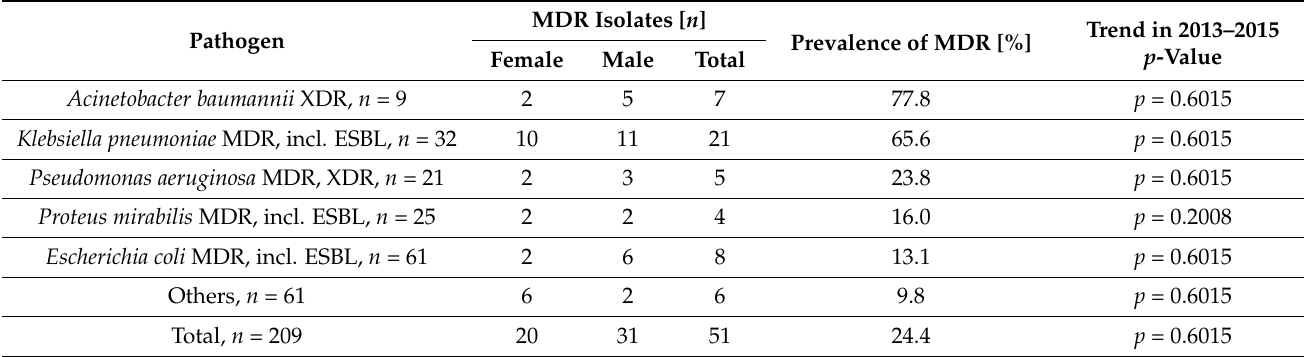
Table 3. Multidrug-resistant micro-organisms isolated from catheter-associated urinary tract infections in the Clinical Department of Orthopedic, Traumatic, Oncological, and Reconstructive Surgery in 2013–2015.